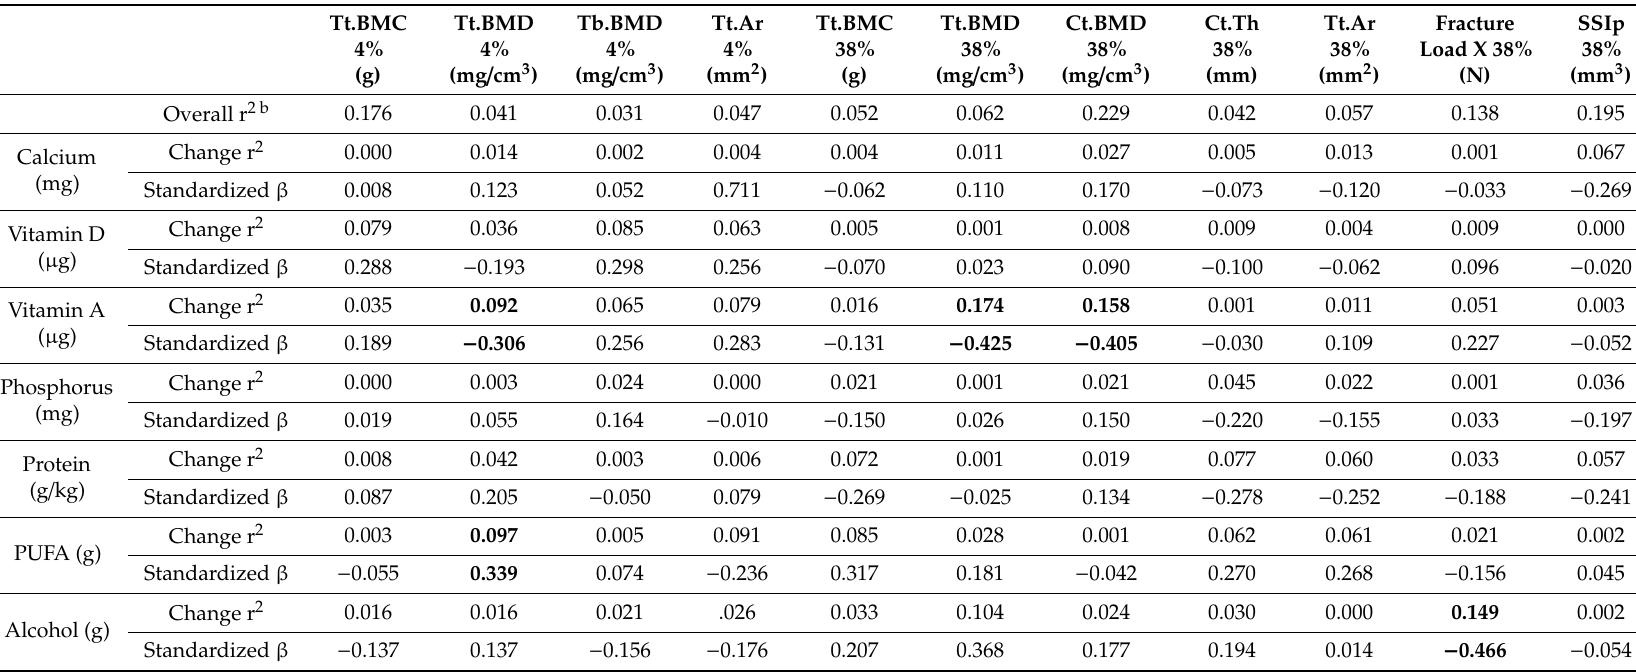
Table 5. Sex- and age- adjusted linear regression coe ffi cients for the influence of dietary intake on bone mass and